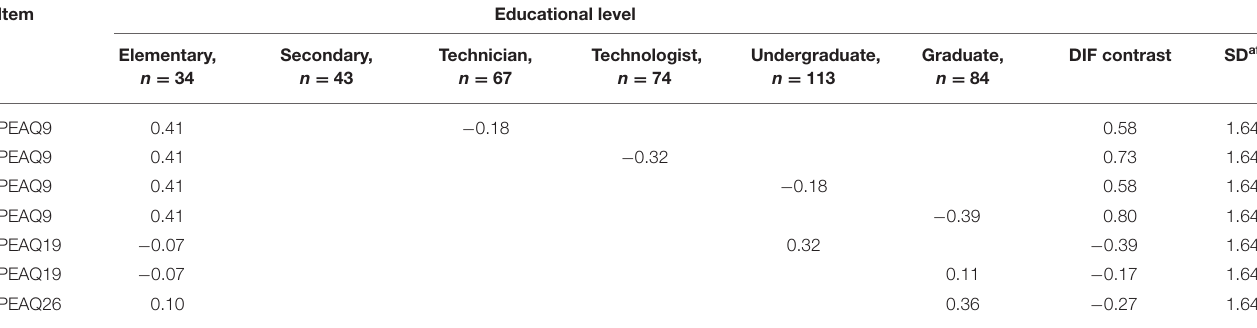
TABLE 4 | Mantel Haenszel statistics ( p < 0.05) of the PEAQ items with the educational level bias variable ( N = 415).